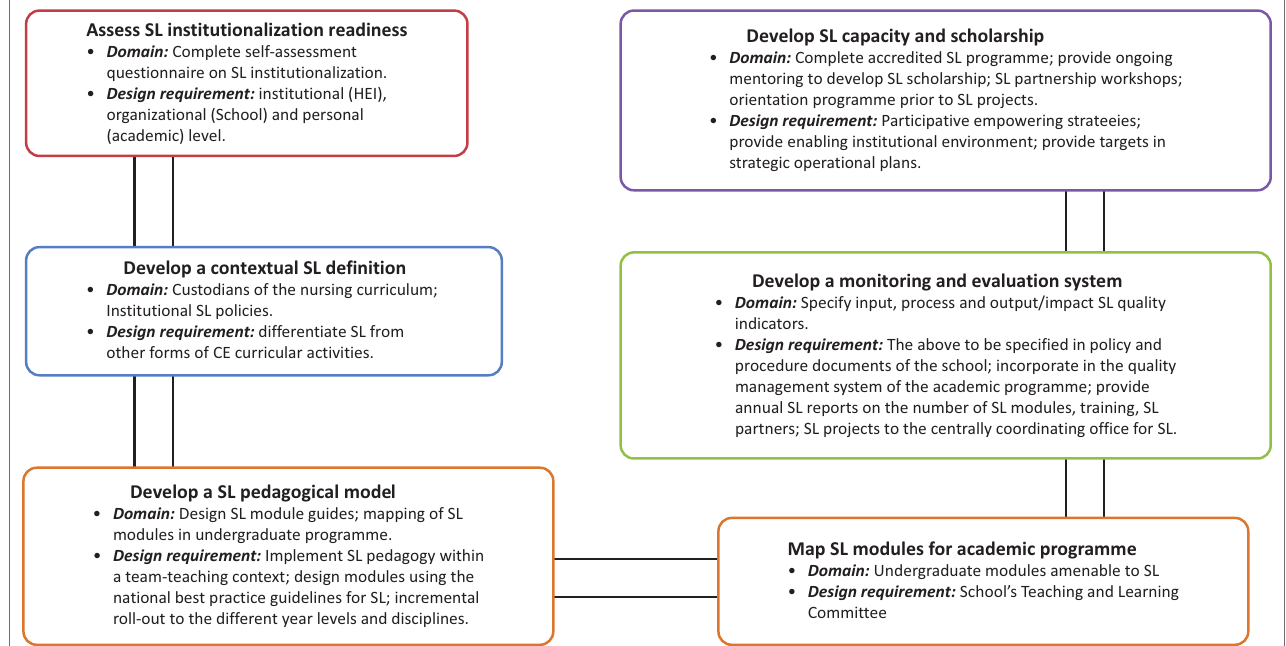
FIGURE 3: Activities of the service-learning implementation framework (Julie